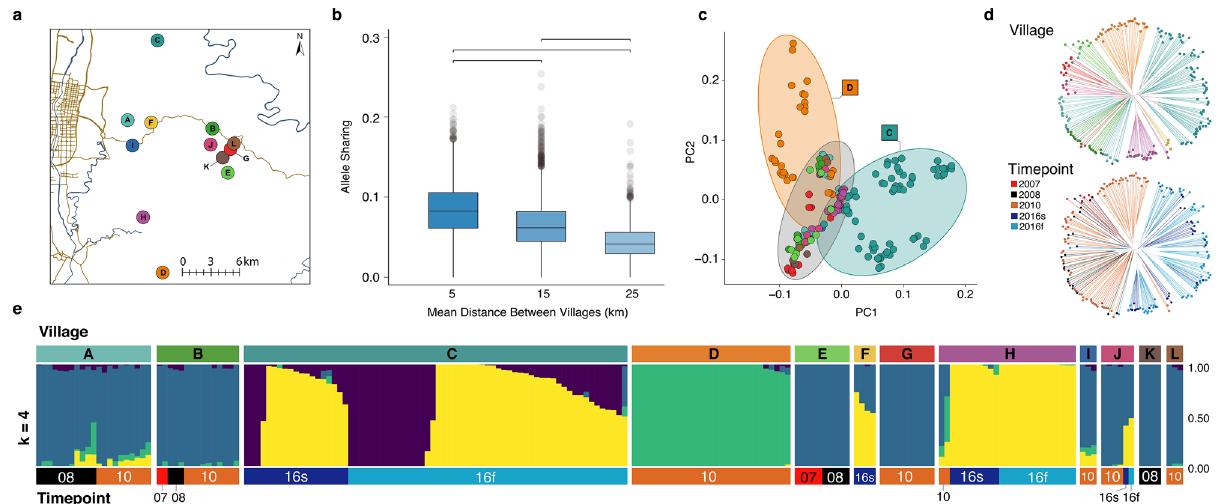
Figure 1. Genetic and geographic structure of Schistosoma japonicum miracidia sampled in Sichuan, China. ( a ) Map showing locations of the 12 villages sampled, indicated by colored dots. Yellow lines represent major roads and blue lines indicate rivers and major streams. The map was created with ArcGIS ArcMap 52 (version 10.6; https:// deskt op. arcgis. com/ en/ arcmap/). ( b ) Proportion of rare alleles shared among villages with mean, interquartile ranges, and outliers beyond the 2.5th percentile shown. Inter-village distances are Euclidean. All comparisons were significantly different (all p < 2.2 × 10 –16 ; Mann–Whitney U test). ( c ) Principal component analysis (PCA) of genetic variation from 200 miracidia across all 12 villages. The first two principal components (PC1 and PC2) respectively account for 4.2% and 2.5% of the genetic variation among individuals. ( d ) Neighbor-joining tree of miracidia colored by village (top) and sampling timepoint (bottom). ( e ) ADMIXTURE plot showing optimal k = 4 genetic clusters grouped by village and sampling timepoint. Timepoints are labeled with year of collection (e.g., 2008 in d or 08 in e ); Summer and late Fall 2016 collections are labeled with small s or f,